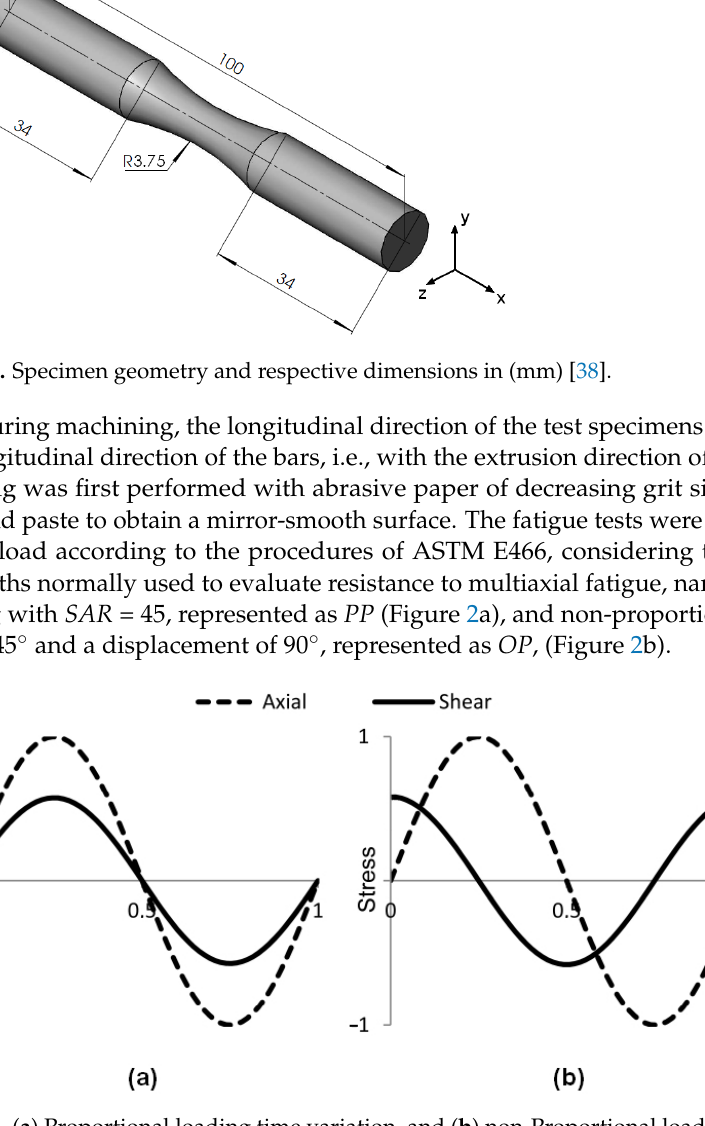
Figure 2. ( a ) Proportional loading time variation, and ( b ) non-Proportional loading time variation.